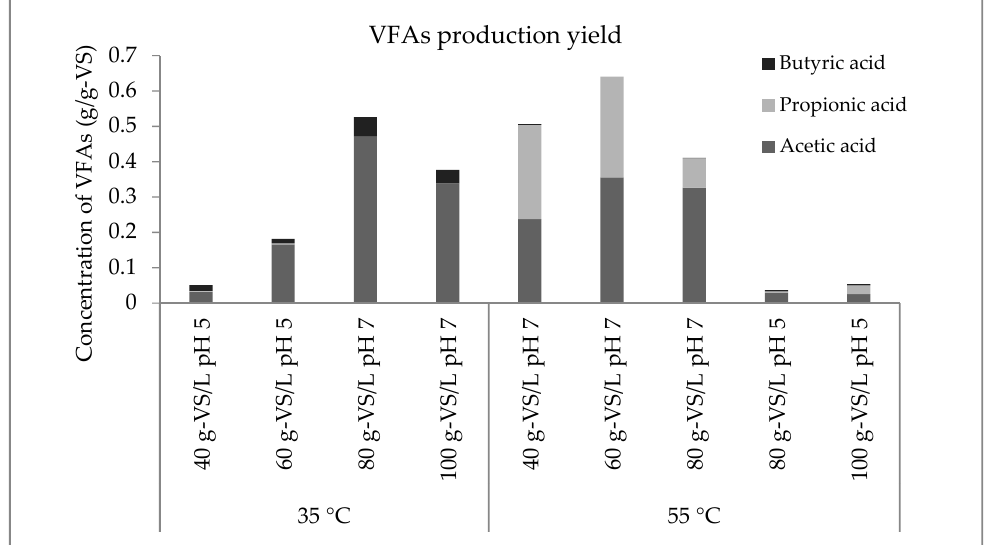
Figure 5. Acetic acid, propionic acid and butyric acid production from batch fermentation .